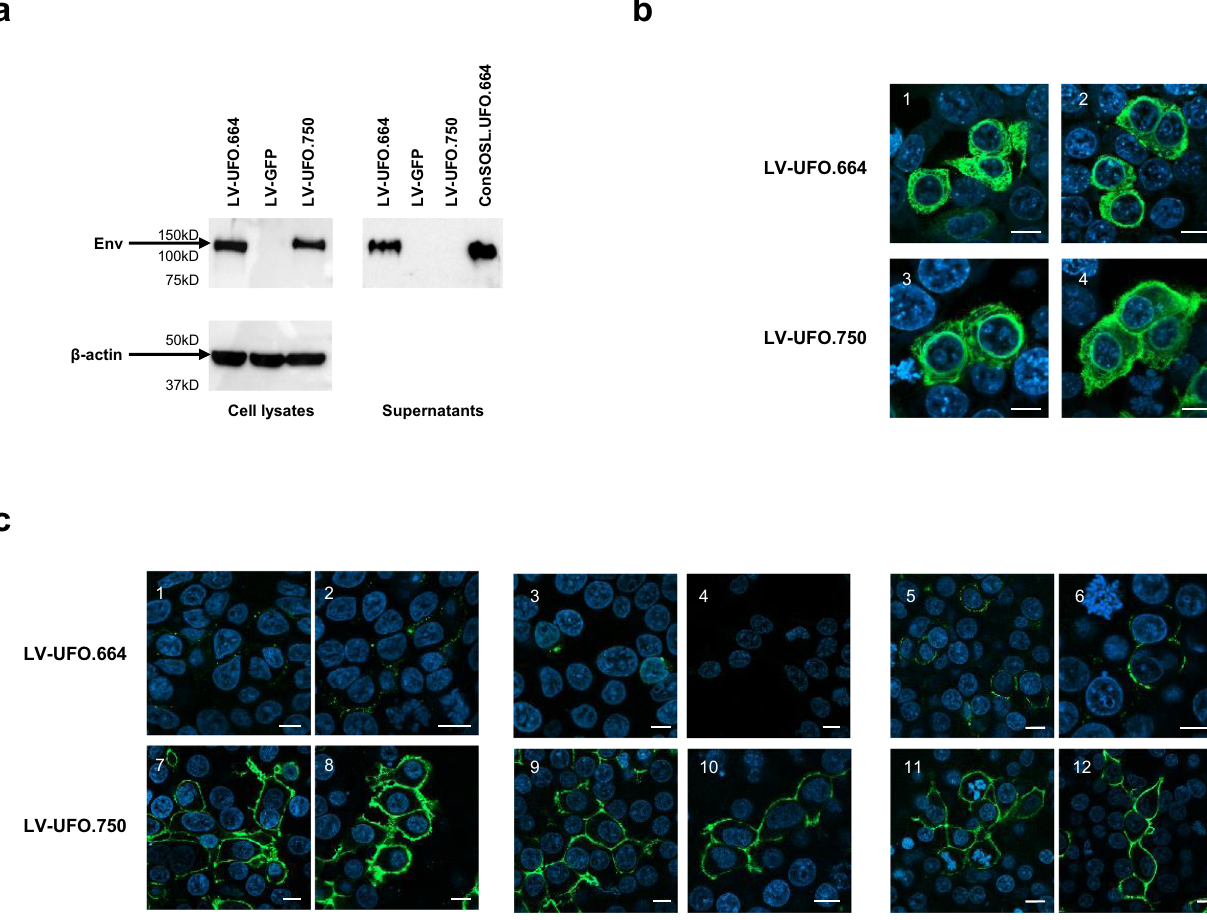
Fig. 2 ConSOSL.UFO.664 and ConSOSL.UFO.750 expression from lentiviral vectors. 293T Lenti-X cells were transduced with 5 MOI of LV- UFO.664 or LV-UFO.750. a Six days post-transduction a WB on cells lysates (left panels) and supernatants (right panel) was performed using anti-Env 2G12 bNAb (top panels). β -actin was used as loading control (bottom panel). ConSOSL.UFO.664 recombinant protein (1 µg) and cells transduced with LV-GFP were used as positive and negative controls, respectively. All blots derive from the same experiment and were processed in parallel. b Transduced cells were also analyzed by CLSM after intracellular staining with the 2G12 bNAb. c CLSM analysis of 293T Lenti-X cells transduced with LV-UFO.664 or LV-UFO.750 after membrane staining with anti-Env 2G12 bNAb (panels 1 – 2, 7 – 8) or membrane staining with trimer-speci fi c PGT145 (panels 3 – 4, 9 – 10) and PGDM1400 bNAbs (panels 5 – 6, 11 – 12). Anti-human IgG Alexa Fluor 488 was used as secondary Ab. Nuclei were stained in blue with DAPI and scale bars is 10 μ m. Two images representing single central optical sections are shown for each bNAb staining. Shown are results from one representative of n = 3